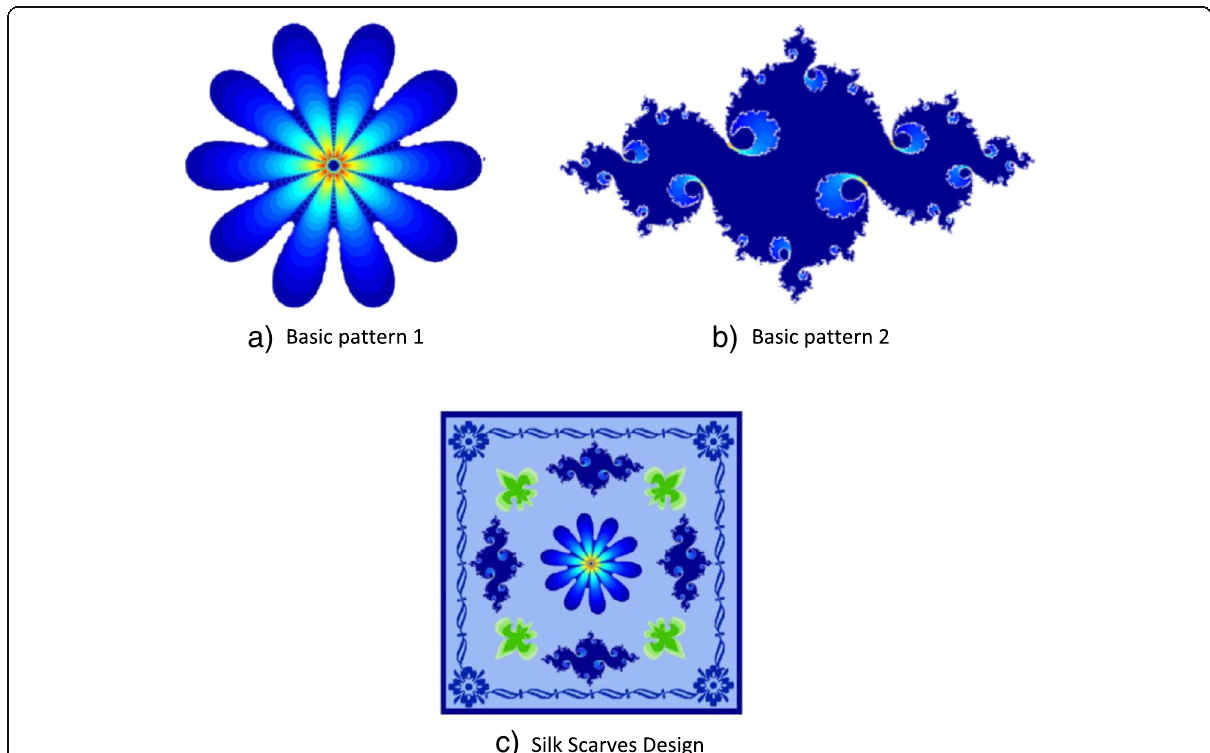
6.2 Application of fractal pattern in garment fabric printing pattern